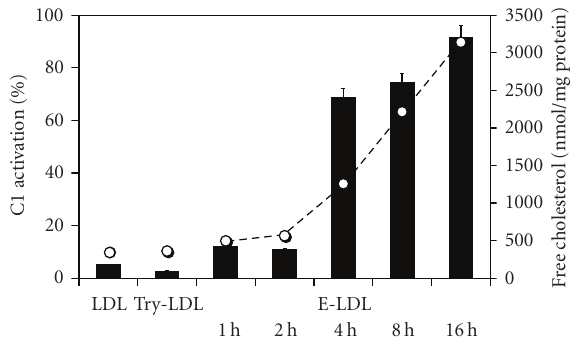
Figure 2: C1 activation by E-LDL particle: correlation with the amount of unesterified cholesterol generated. LDL (1mg/mL) was treated with 20 μ g/mL trypsin for 2 h at 37 ◦ C and then with 320milliunits/mL CEase for the indicated periods at 37 ◦ C. The lipid fraction from each sample was extracted and incorporated into vesicles. Each vesicle was tested for its C1-activating ability (black bars). The cholesterol content of each lipid fraction (open circles) was determined by reverse-phase HPLC. LDL: native LDL; Try-LDL: trypsin-treated LDL (taken from [15], with permission).